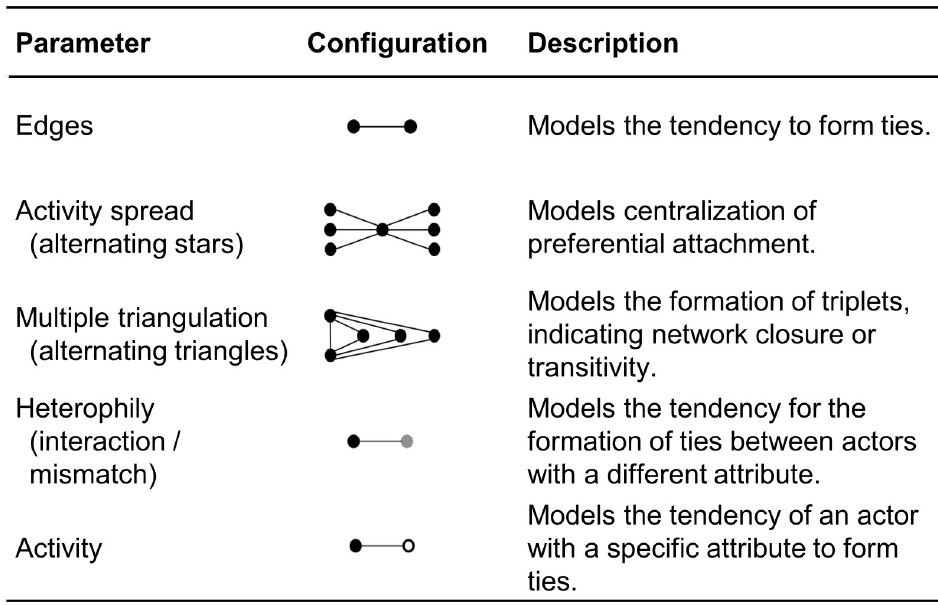
Fig 1. Description of included ERGM